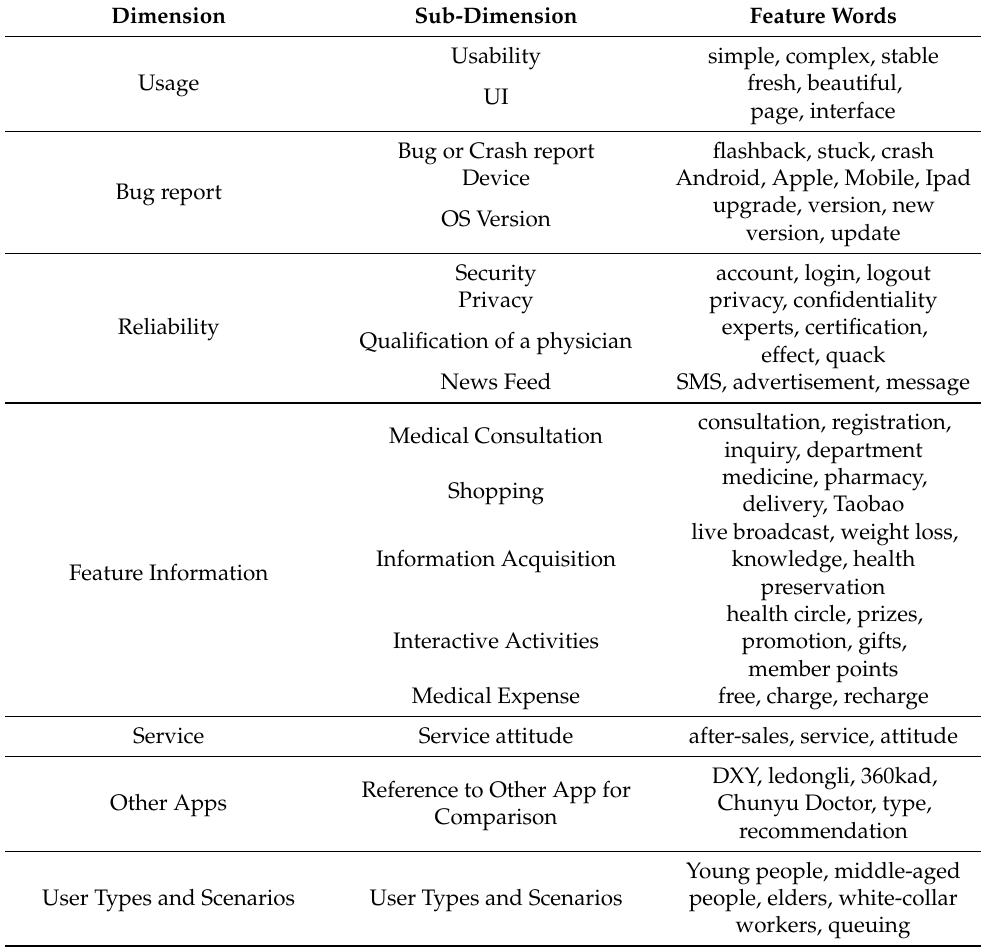
Table 1. Dimensions and Feature Words